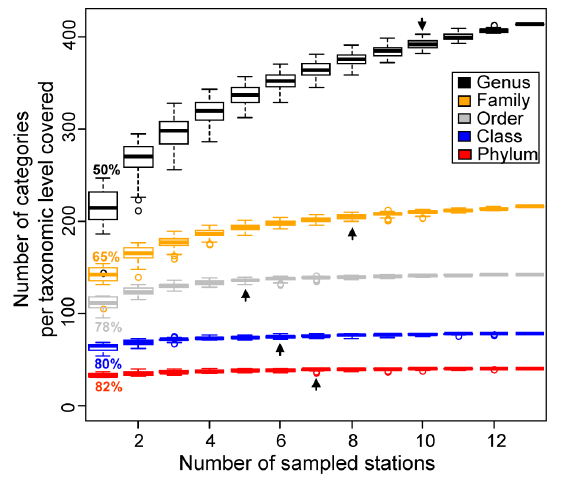
Figure 3. Accumulation curves per taxonomic category based on MPTS data. Arrows indicate how many stations are needed to recover 95% of categories per taxonomic level. The percentages indicated for n=1 station correspond to how much diversity would be recovered on average by randomly sampling only one station.